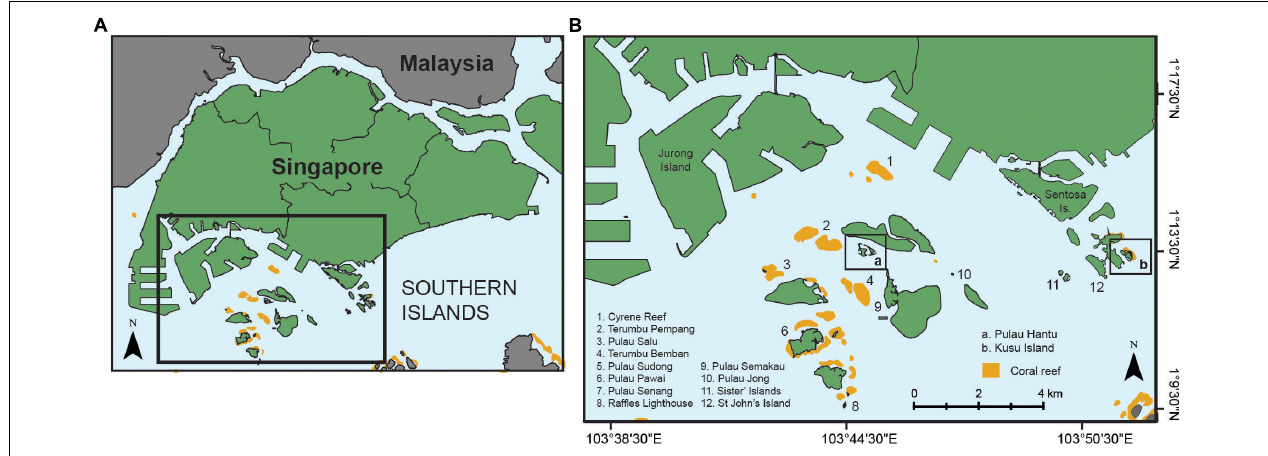
FIGURE 1 | Location of (A) Pulau Hantu and (B) Kusu Island within the Southern Islands group positioned off the south coast of Singapore